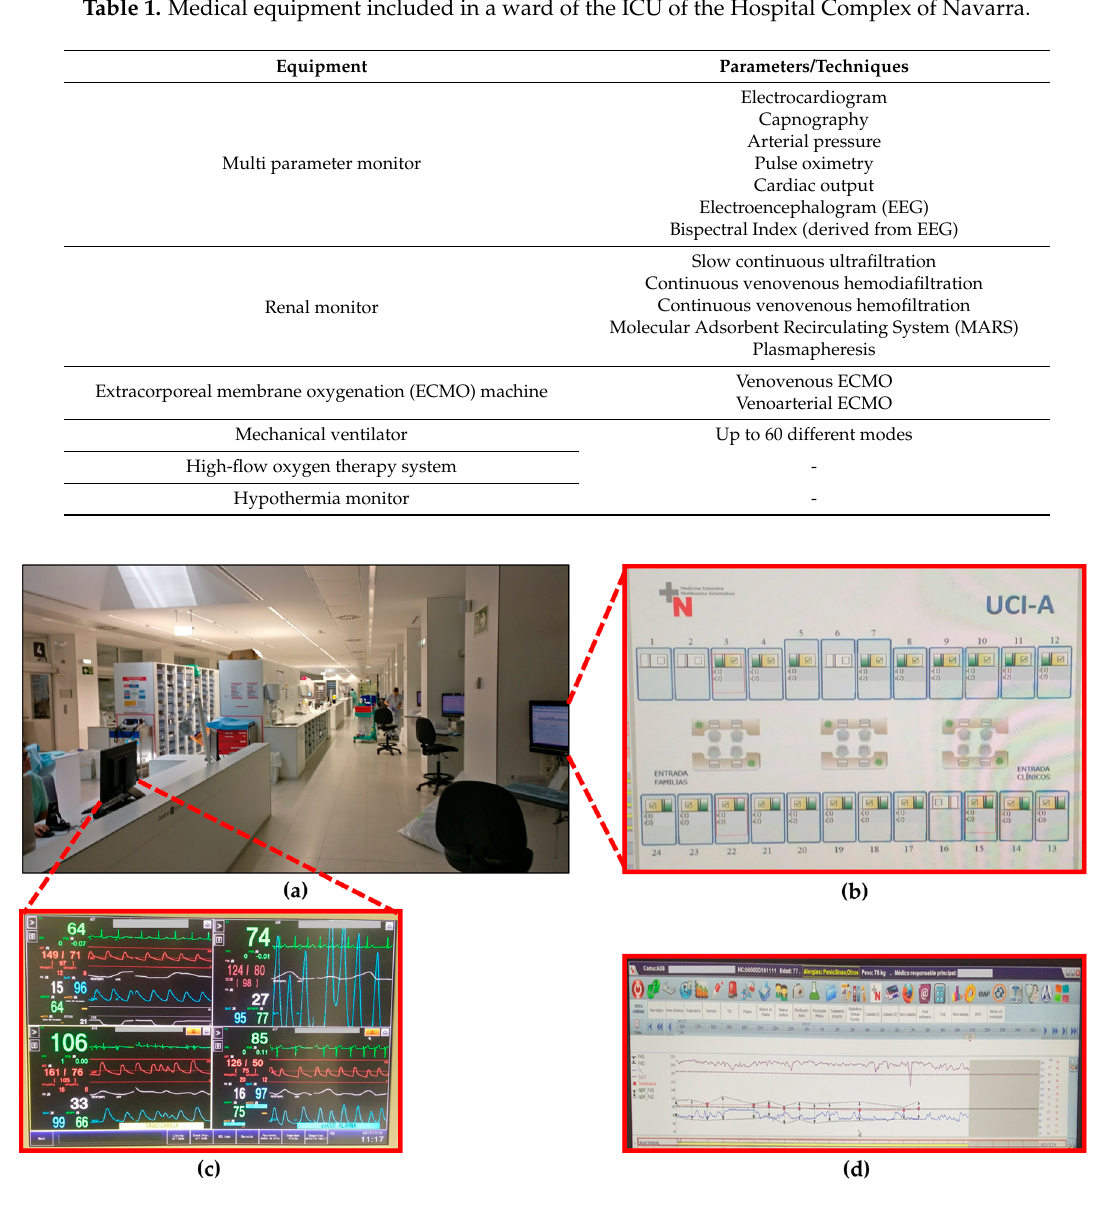
Figure 2. Screenshot of different tools of the management software of ICU-A: ( a ) ICU-A; ( b ) Boxes occupation tool; ( c ) Vital signs graphs; and ( d ) Monitored parameters screenshot.